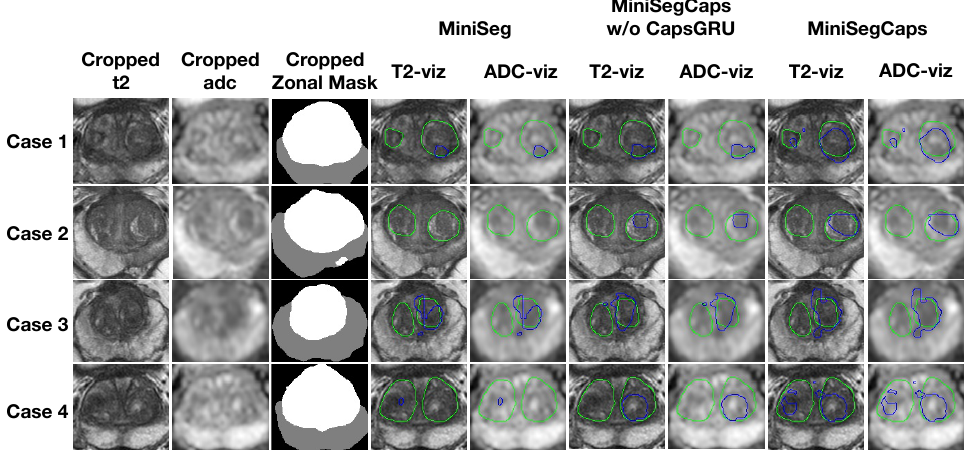
Figure 6. Visualization of benign nodule (e.g., BPH) segmentation results among different cases. The green contour is the ground truth, and the blue contours are from the deep learning